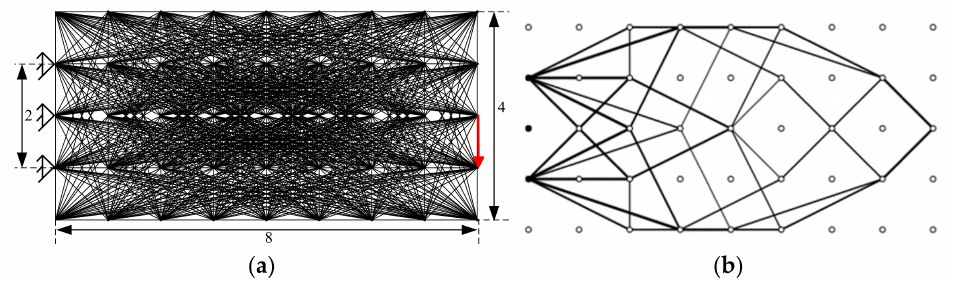
Figure 15. ( a ) Ground structure of the 662-bar truss; ( b ) The solution of the